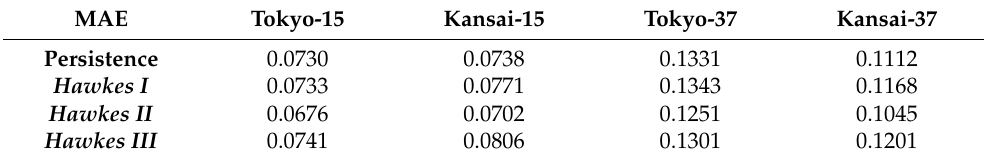
Table 3. Mean absolute error values of the intensity functions for the four investigated models. MAE